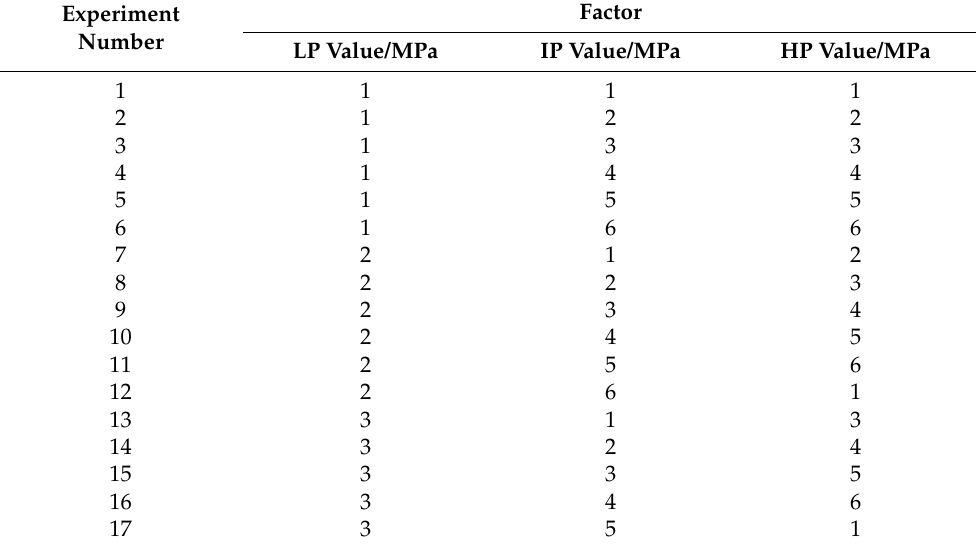
Table 5. Orthogonal test